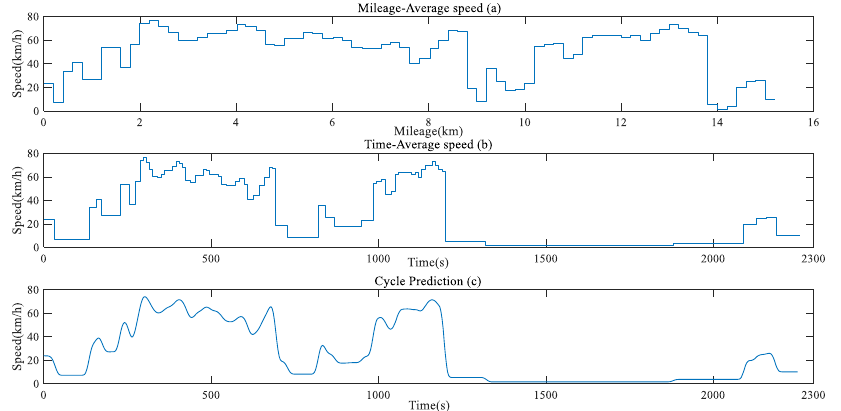
Figure 3. Target travel cycle prediction considering traffic information. ( a ) Mileage-average speed information; ( b ) Time-average speed information; ( c ) Actual road cycle prediction curve in China.